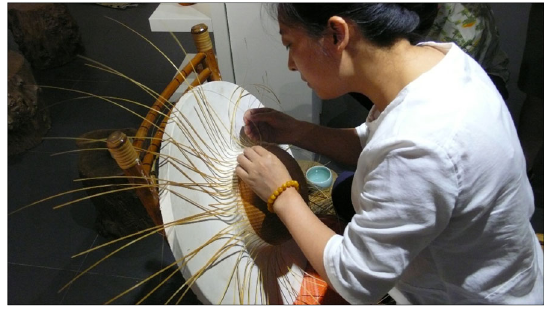
Fig. 4 Bamboo Weaving over Porcelain, M50